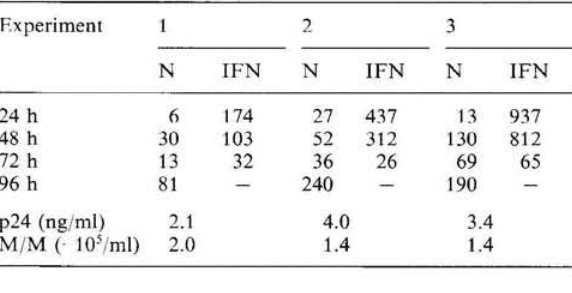
Table 1. Time course of neopterin release (Ν; pmol/ml) and interferon activity (IFN; U/ml) induced by cell-cell interaction